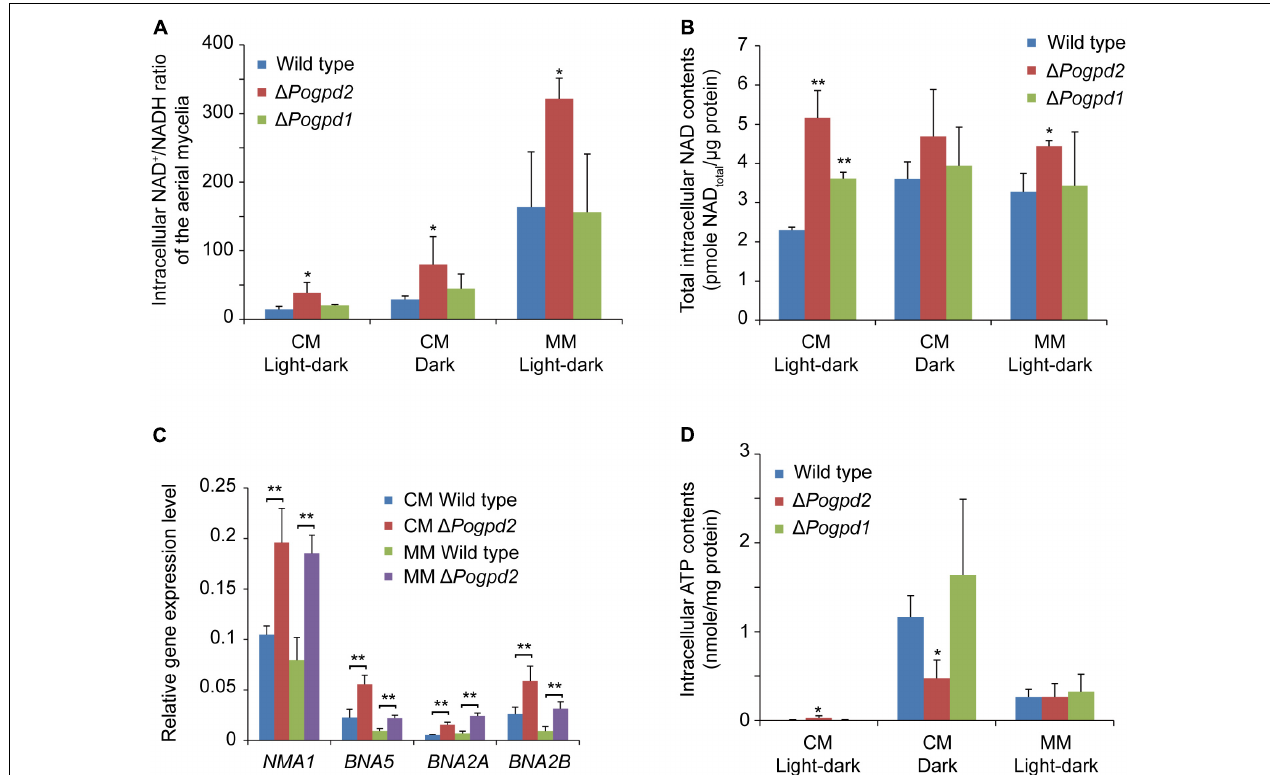
FIGURE 9 | Roles of glycerol-3-phosphate dehydrogenases in NAD + /NADH ratio and intracellular ATP content in Pyricularia oryzae . (A) Intracellular NAD + /NADH ratio in the aerial mycelia of the wild type, (cid:49) Pogpd1 , and (cid:49) Pogpd2 cultured on CM and MM media under a light–dark cycle or a continuous dark condition. (B) Total intracellular NAD content (pmol/ µ g protein) in the aerial mycelia of the wild type, (cid:49) Pogpd1 , and (cid:49) Pogpd2 cultured on CM and MM media under a light–dark cycle or a continuous dark condition. (C) Relative expression level of four NAD biosynthesis genes ( NMA1 , BNA5 , BNA2A , and BNA2B ) in (cid:49) Pogpd2 cultured on CM and MM media under a light–dark cycle. β -TUBULIN and H3 were selected as reference genes. (D) Intracellular ATP content in the aerial mycelia of the wild type, (cid:49) Pogpd1 , and (cid:49) Pogpd2 cultured on CM and MM media under a light–dark cycle or a continuous dark condition. Error bars represent SD. Significant difference compared with the wild type as estimated by Tukey’s HSD test: ∗ P < 0.05 and ∗∗ P <